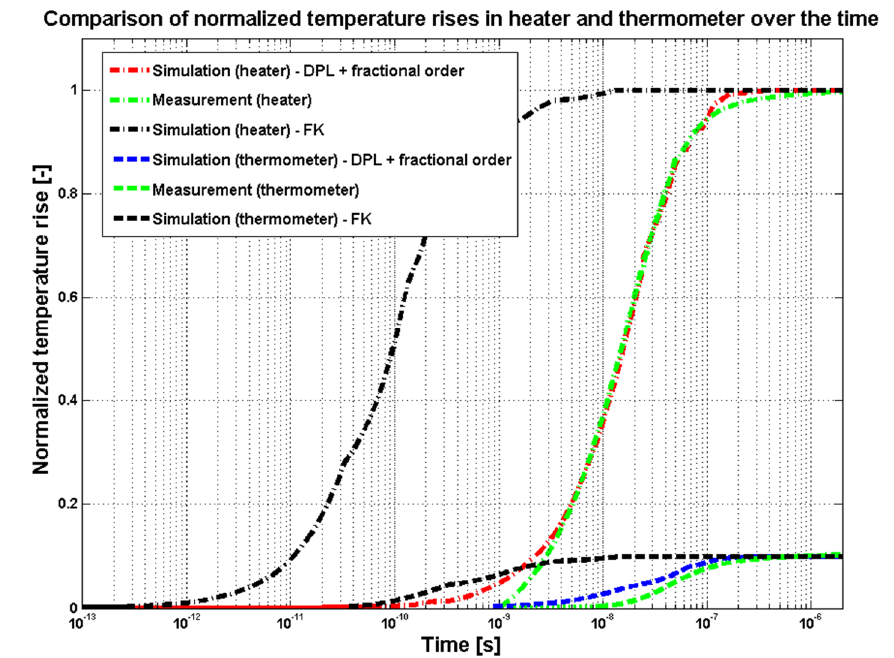
Figure 7. Comparison of normalized temperature rises in heater and thermometer.